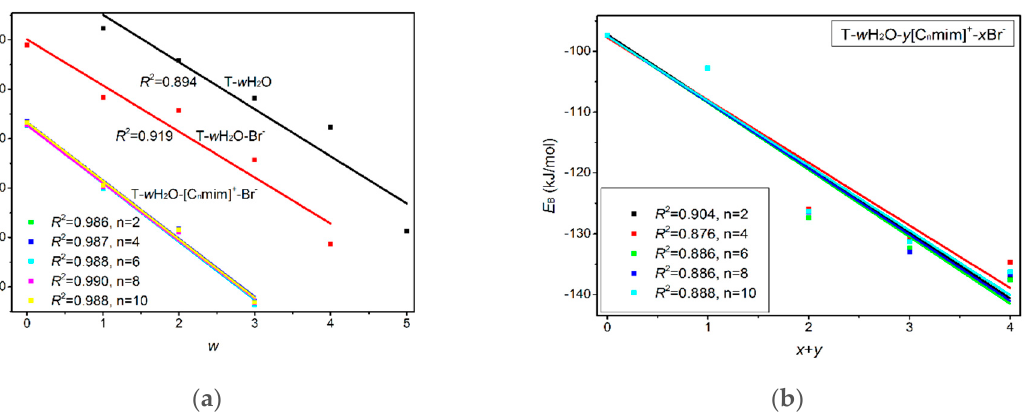
Figure 4. ( a ) Correlations between the E B and number of the explicit water molecule ( w ) for the mi- crohydrates, T- w 1 H 2 O-Br − -1, T- w 2 H 2 O-[C n mim] + -Br − -1, T- w 3 H 2 O-[C n mim] + -2Br − -1, and T- w 4 H 2 O- 2[C n mim] + -2Br − -1 ( n = 2, 4, 6, 8, 10). ( b ) Correlations between the E B and number of the ion ( x + y ) for the microhydrates, T-4H 2 O-Br − -1, T-3H 2 O-[C n mim] + -Br − -1, T-2H 2 O-[C n mim] + -2Br − -1, and T-1H 2 O-2[C n mim] + -2Br − -1 ( n = 2, 4, 6, 8, 10). Tri-ionic T - w 3 H 2 O-[C n mim] + -2Br − hydrates (w 3 = 1, 2) . Sequentially, the